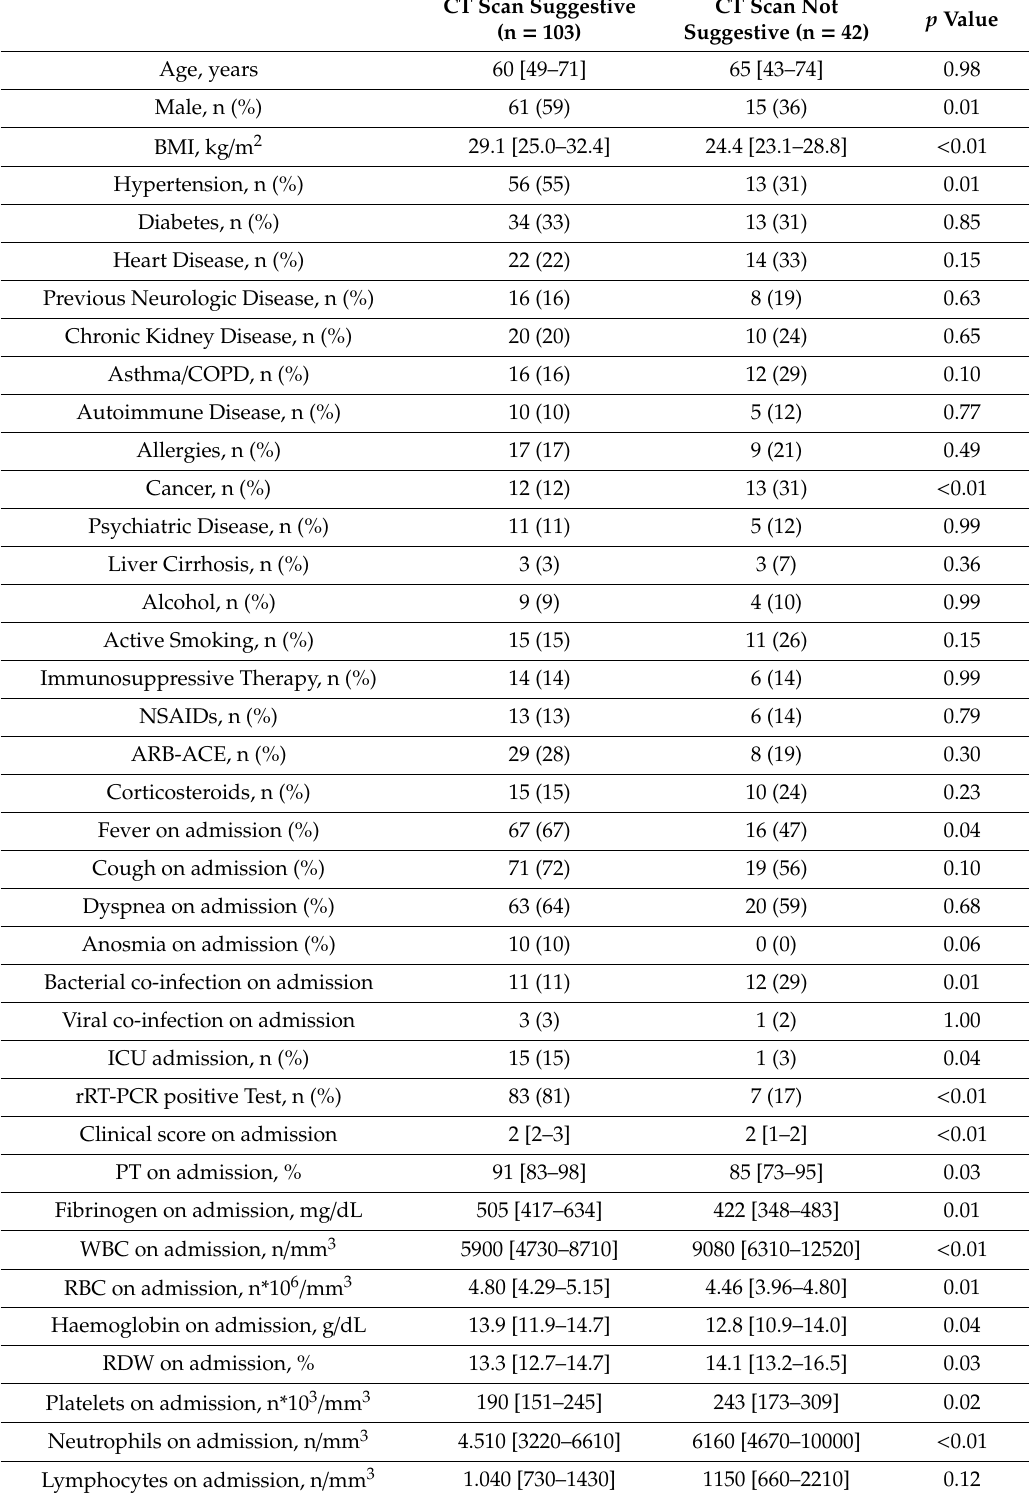
Table 2. Characteristics of study population, according chest CT-scan results on